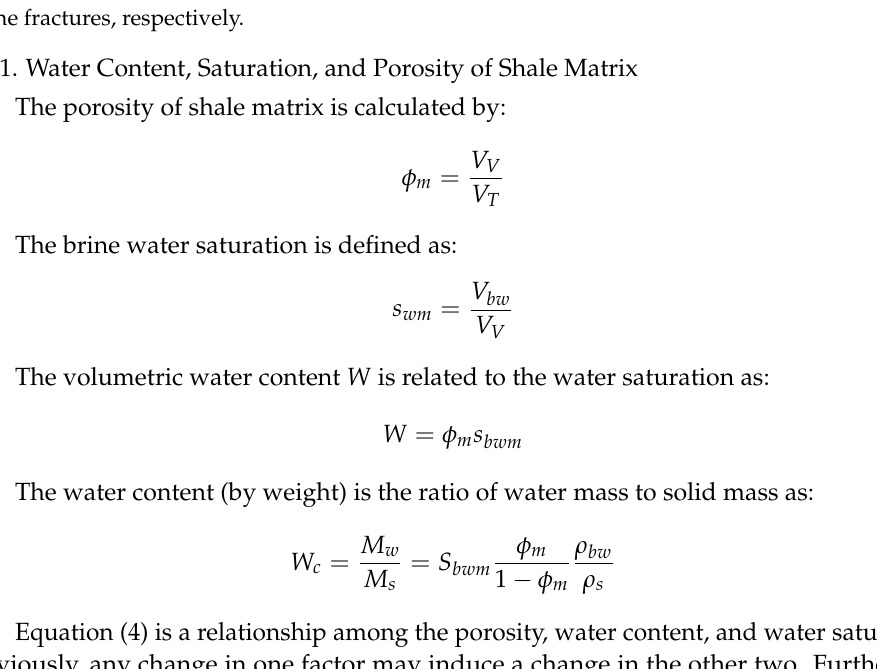
P P , P CO , wf , , 2 m 2 f